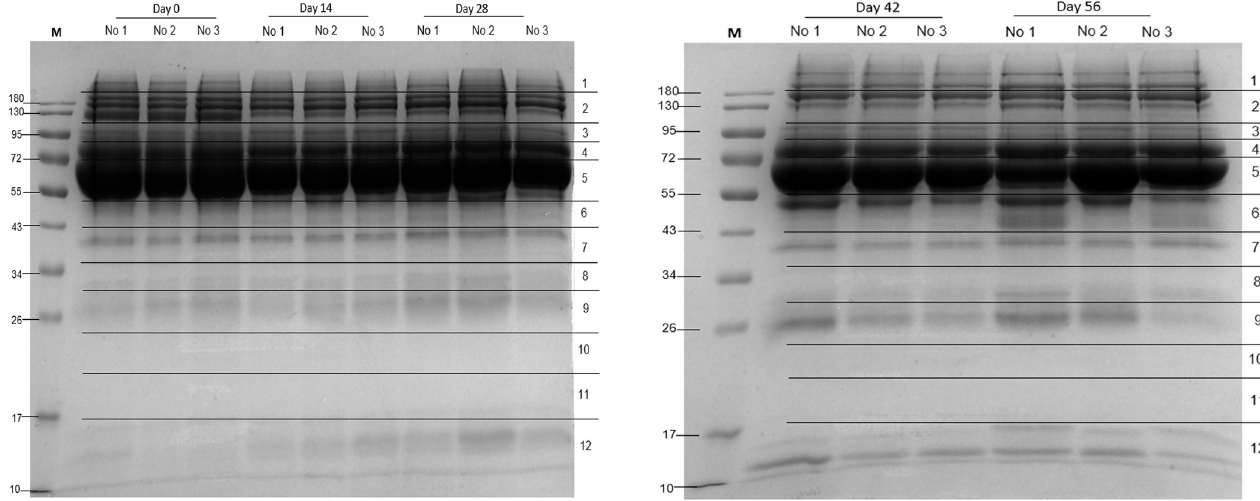
Fig 1. SDS-PAGE analysis of S . mekongi -infected mouse serum at 0- (pre-infection), 14-, 28-, 42-, and 56-days post-infection. M: marker; No. 1–3: mice number 1–3. The 12 horizontal sections represent excised protein bands used in mass spectrometric analysis.